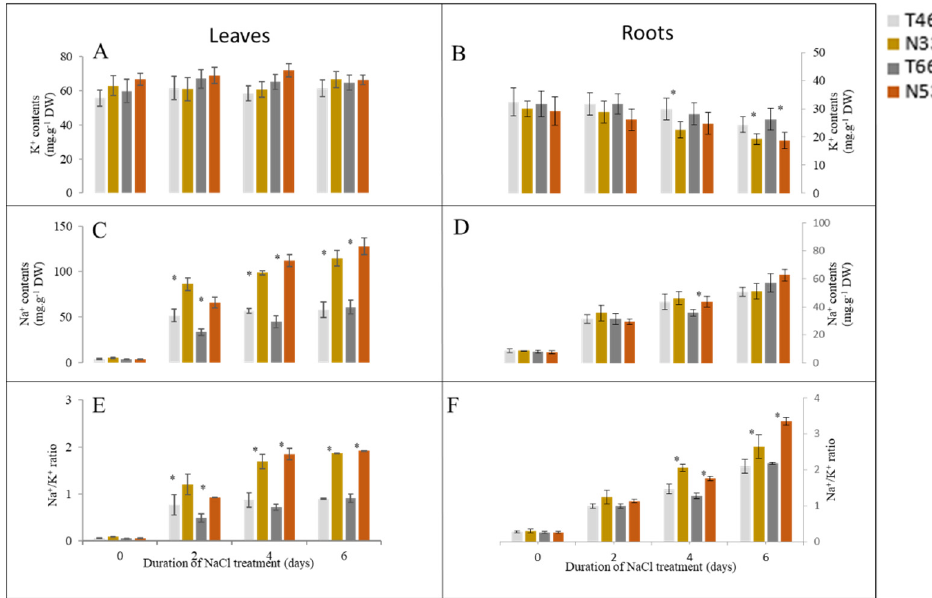
Figure 3. Comparison of Na + content ( C , D ), K + content ( A , B ) and Na + /K + ratio in ( E , F ) leaves ( A , C , E ) and roots (B,D,F) of two pairs of NILs at 0, 2, 4, 6 days after 300 mM NaCl. * indicates significant differences among NILs ( p < 0.05, Student’s t ‐ test). di ff erences among NILs ( p < 0.05, Student’s t